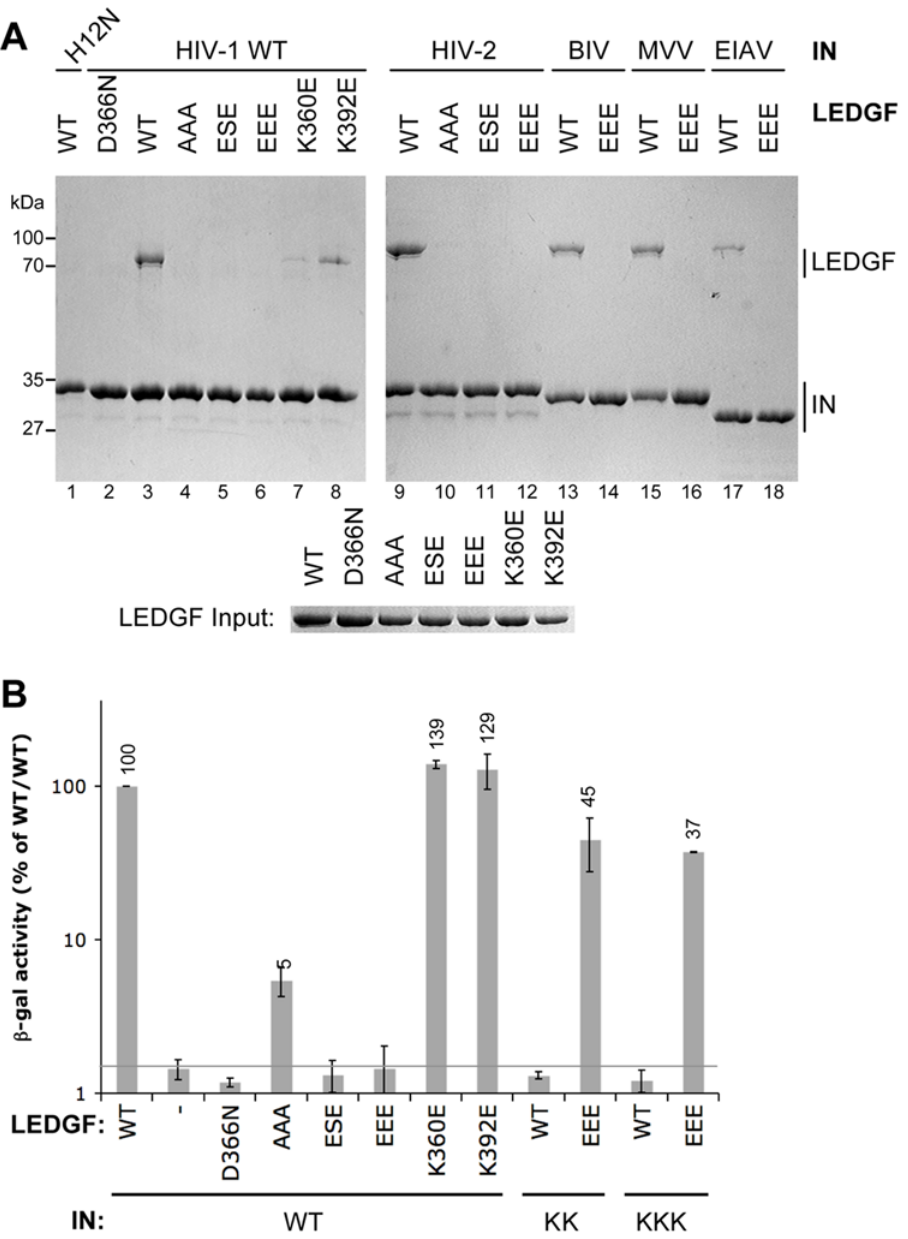
Figure 3. Functional Importance of the NTD–IBD Charge–Charge Interface for the Lentiviral IN–LEDGF Interaction. (A) Pull down experiments. Non-tagged WT, D366N, AAA, ESE, EEE, K360E, or K392E LEDGF proteins were incubated with C-terminally His 6 -tagged forms of HIV-1 IN mutant H12N, WT HIV-1 IN, HIV-2 IN, BIV IN, MVV IN, or EIAV IN (as indicated) in the presence of Ni-NTA agarose. Bound proteins were separated in 11% sodium dodecyl sulfate polyacrylamide gels and visualized with Coomassie Blue. Input quantities of LEDGF proteins are shown below the main gel. (B) Yeast two-hybrid analyses. The IN–LEDGF interaction assay [22,38] is based on transactivation of the b -galactosidase gene in S. cerevisiae indicator cells Y187. Relative b -galactosidase activities produced by yeast co-transformed with the indicated IN and LEDGF IBD mutants are shown on a log scale, with 100% corresponding to the WT bait/WT prey condition. The background of the assay is defined by WT IN in the presence of empty prey vector and is shown as a gray line. Each bar represents a mean value; standard deviations were calculated based on results of quadruplicate measurements. Values exceeding the background are shown atop the bars. doi:10.1371/journal.ppat.1000259.g003 with the complementary EEE LEDGF mutant, generating , 40% of WT-WT b -galatosidase activity and furthermore, it failed to interact with WT LEDGF (Figure 3B). The double HIV-1 IN E10K/E13K (KK) mutant bearing charge reversals at the two ends in a concerted fashion, their recombinant forms are typically more conserved acidic positions (Figure 2B) likewise gained the more proficient at half-site integration ( i.e. integration of a single ability to interact with EEE LEDGF while displaying no detectable viral DNA end into one strand of a target DNA molecule). The binding to the WT protein in this assay (Figure 3B). relative efficiencies of concerted and half-site integration processes